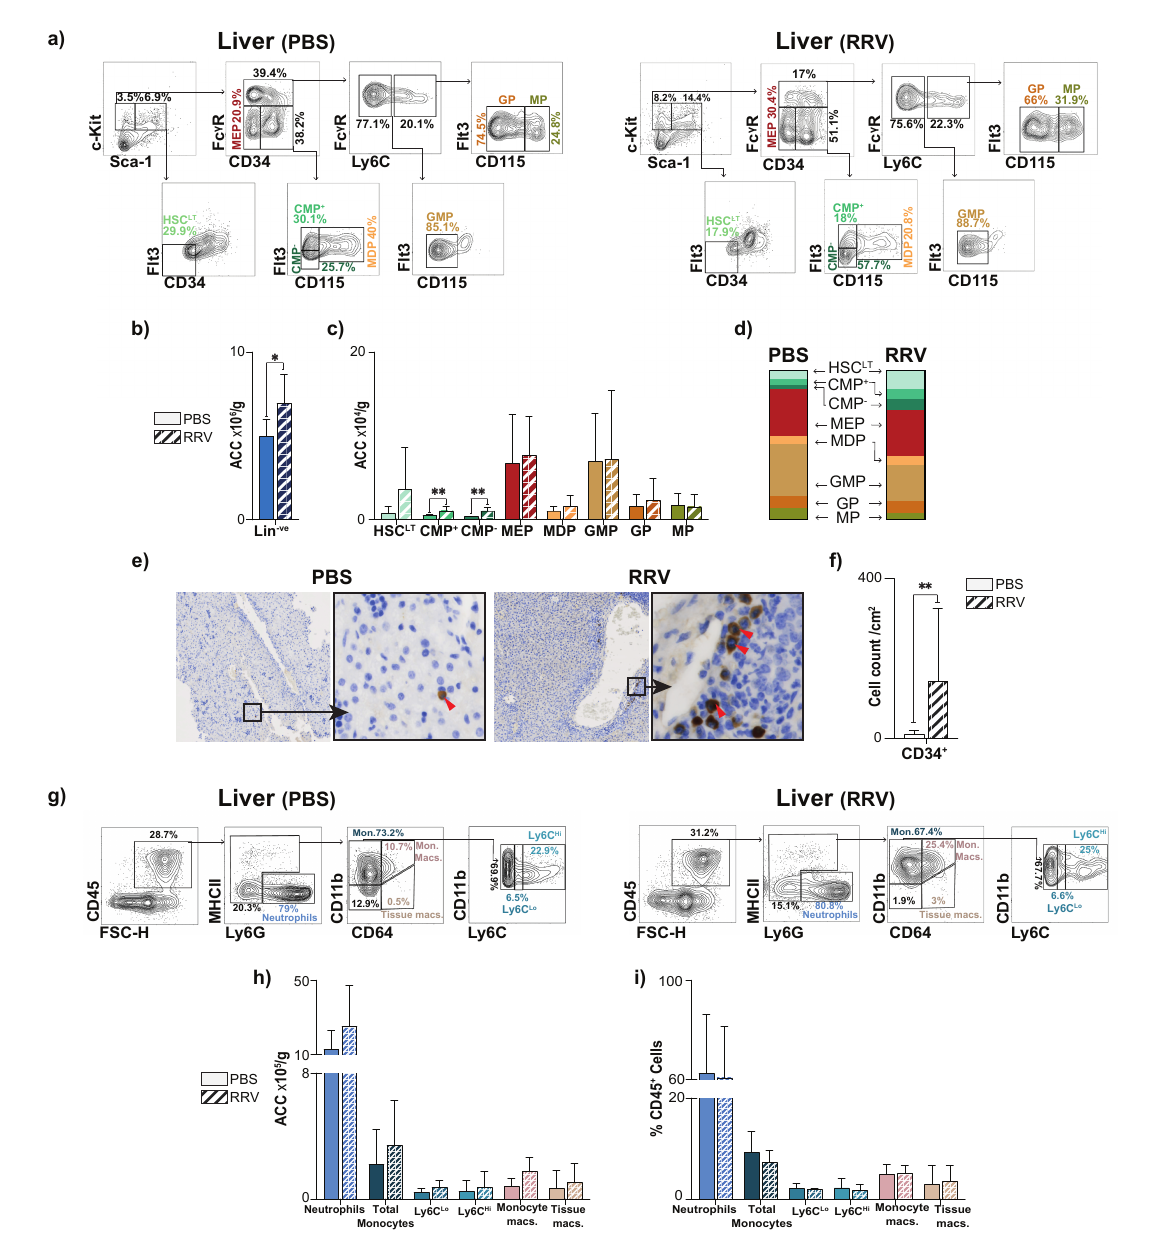
Figure 3. Perinatal liver injury results in the expansion of myeloid progenitors in the neonatal liver. ( a ) Representative flow plots demonstrating gating strategy of hematopoietic stem cells (HSC LT ), common myeloid progenitors (CMP), and terminal myeloid progenitors (TMP) in liver of PBS- and RRV-injected 3-day-old (P3) mice. Quantification of absolute cell counts (ACC) of ( b ) lineage negative (Lin − ve ) cells and ( c ) HSC LT s, CMPs, TMPs in P3 livers from PBS- ( n = 6) and RRV-injected ( n = 7) mice. ( d ) Relative fractions of HSC LT , CMP, and TMP populations in P3 livers from PBS- ( n = 6) and RRV-injected ( n = 7) mice. ( e ) Representative P3 livers in the setting of PBS and RRV with red arrows marking immunohistochemistry-stained CD34 + cells. ( f ) Quantification of CD34 + cells at P3 in PBS- ( n = 6) and RRV-injected mice ( n = 9). High-power images are at 40 × magnification. ( g ) Representative flow plots demonstrating gating strategy of mature myeloid CD45 + populations in liver of PBS- and RRV-injected 3-day-old (P3) mice. ( h ) Quantification of ACC of mature myeloid populations in the liver of PBS- ( n = 3) and RRV-injected ( n = 5) mice at P3. ( i ) Quantification of %CD45 + leukocytes of mature myeloid populations in the liver of PBS- ( n = 4) and RRV-injected ( n = 8) mice at P3. p -value * < 0.05, ** <0.01. Error bars represent mean ±